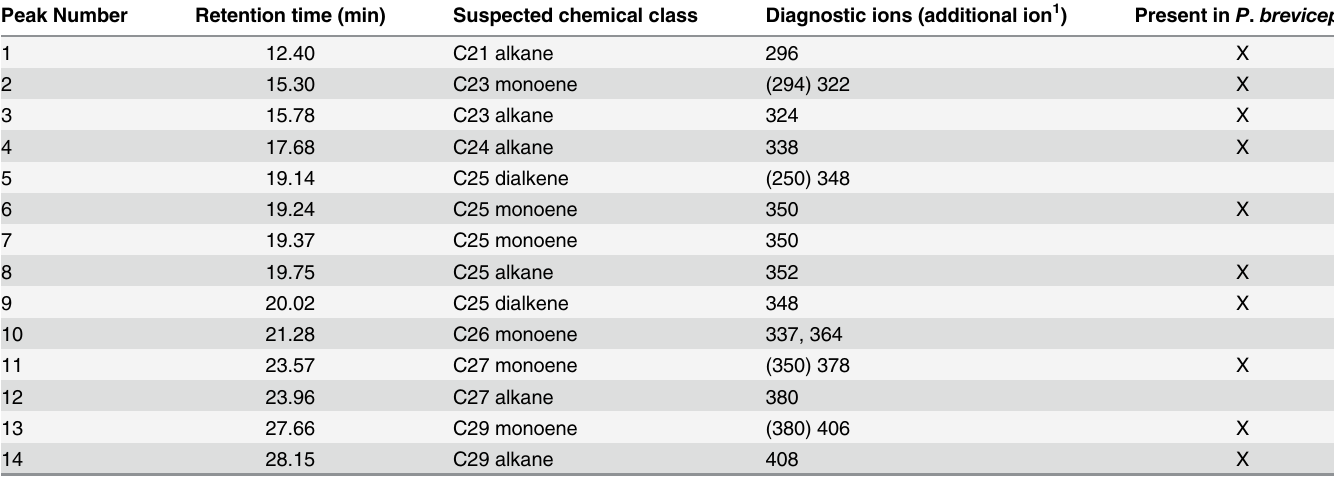
1 These peaks, though diagnostic for proper identi fi cation of peaks used in this study, were not taken into account when determining the chemical class indicated